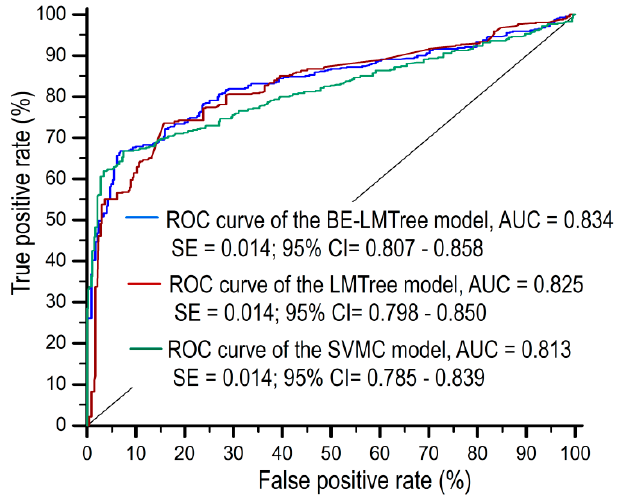
Figure 10. Receiver Operating Characteristic (ROC) curve and Area Under the curve (AUC) of the BE-LMTree model, the LMTree model, and the SVMC model using the validation dataset. SE: Standard Error; CI: Confidence Interval.